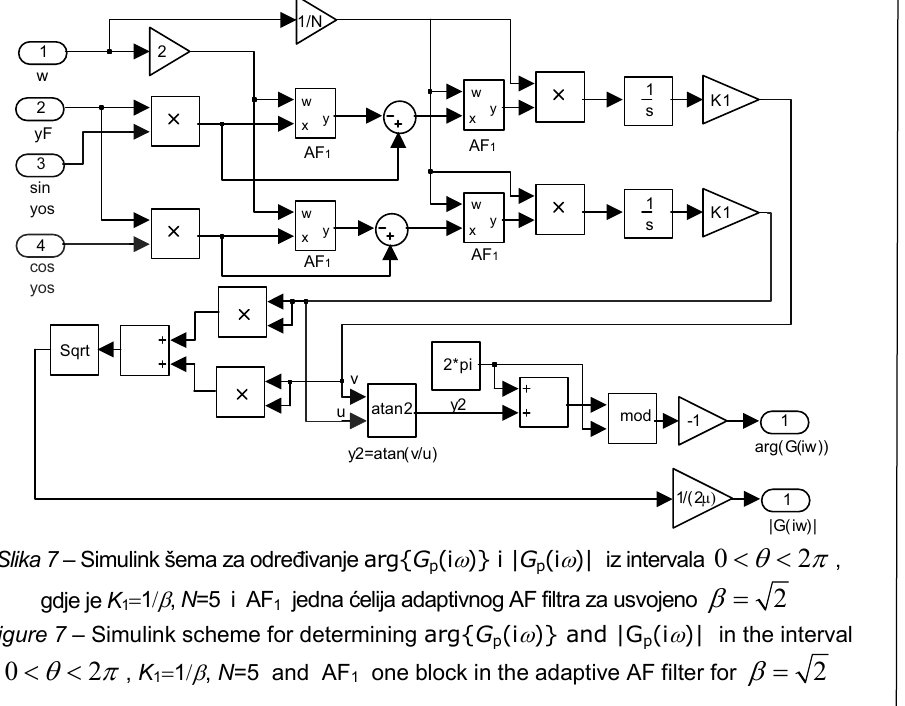
Figure 7 – Simulink scheme for determining arg{ G p (i ω )} and |G p (i ω )| in the